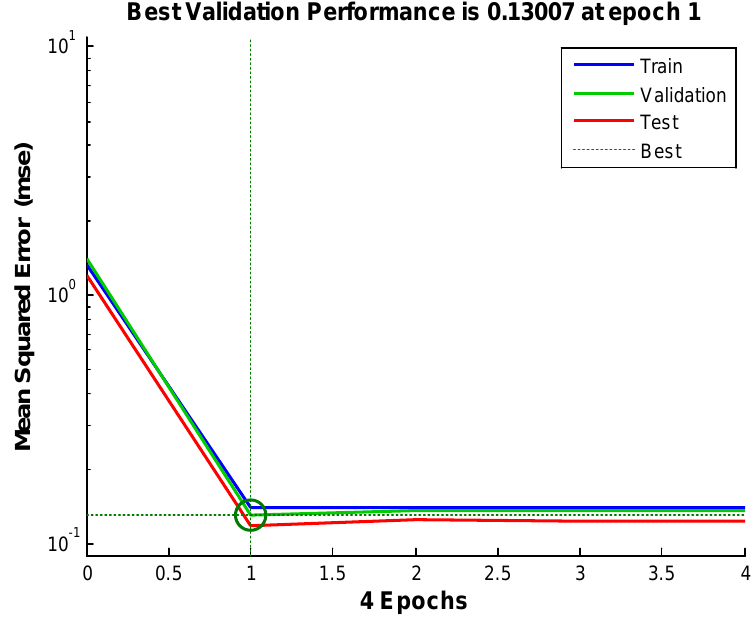
Figure 9. Neural network-based data assimilation result for station 2.